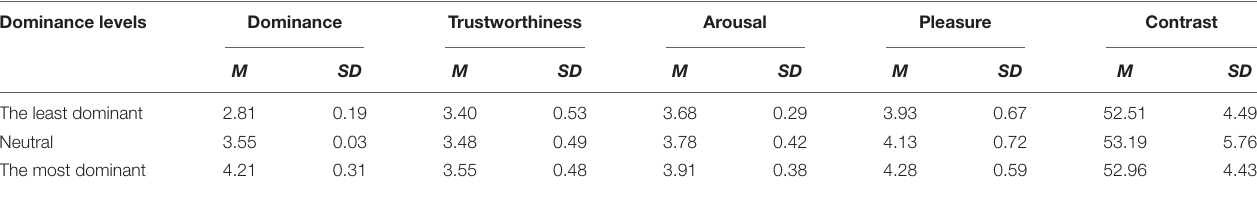
TABLE 2 | Mean and standard deviation of dominance, trustworthiness, arousal, pleasure, and contrast of the 66 faces. Dominance